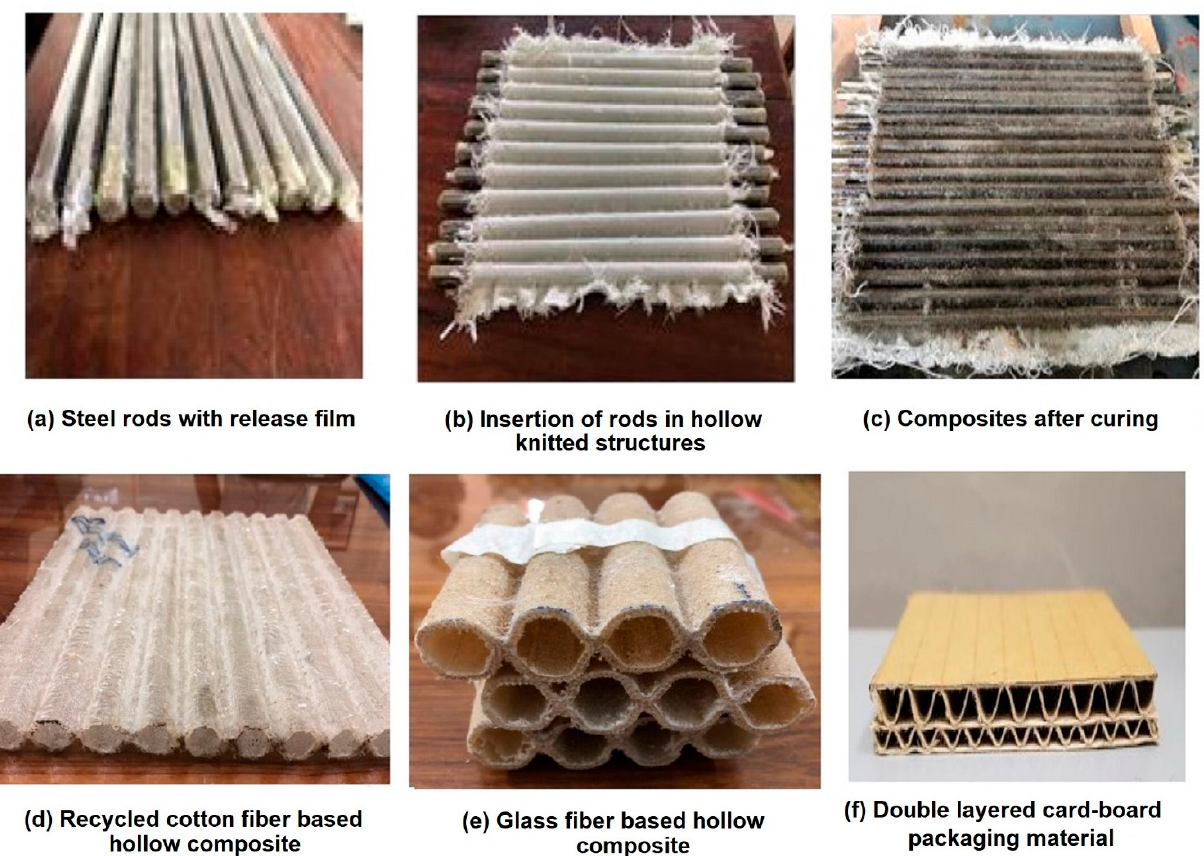
Figure 2. Photographs of developed composite samples versus double-layered cardboard.